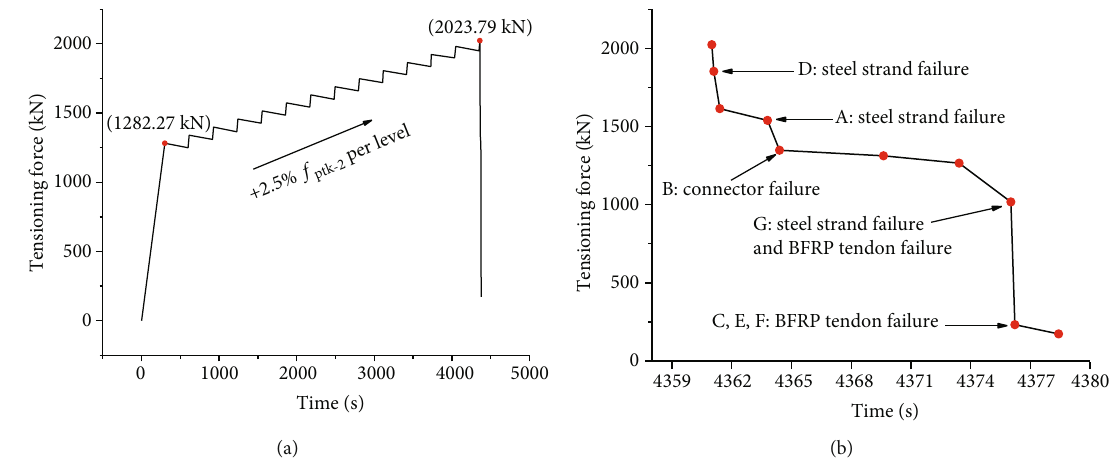
Figure 12: The tensioning process of this large-tonnage BFRP anchor cable: (a) the tensioning force with time and (b) the tensioning force with time after the ultimate strength.